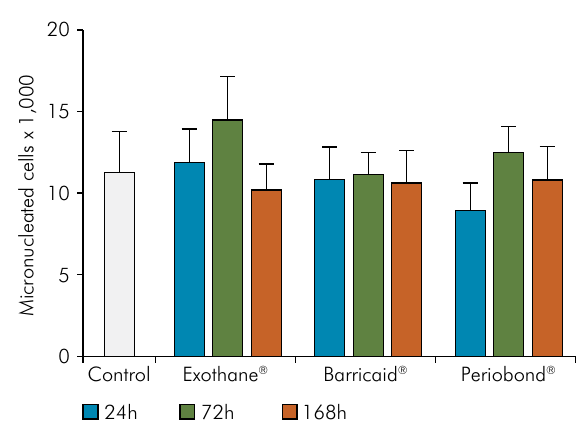
Figure 2. Number of micronucleated cells (MN) per 1,000 cells after after exposure to 24h, 72h, and 168 h eluates of periodontal dressing. All comparisons resulted in the absence of statistically significant differences (p > 0.05).